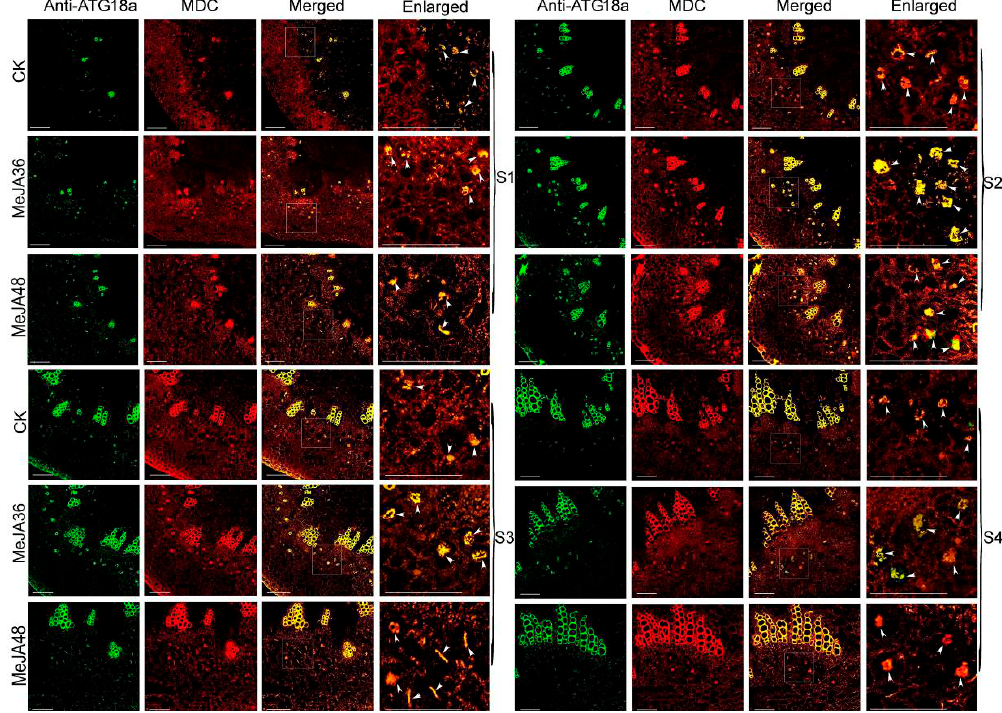
Figure 7. Autophagy activation monitoring by colocalization analysis of anti-ATG18a antibody-Alexa Fluor 488 and MDC in laticifers of Euphorbia kansui . S1: the differentiation stage of the primary meristem of stems. S2–S3: the developing stage of the primary structure of stems. S4: the developing stage of the secondary structure of stems. Laticifers were depicted with white arrows. Bars = 100 nm.